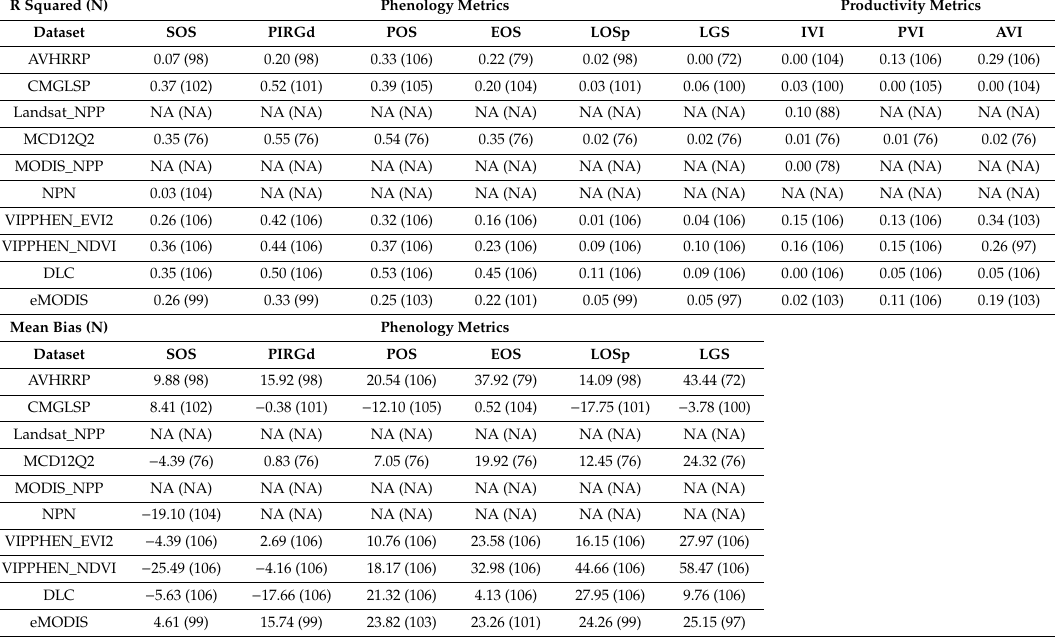
Table A2. Overall